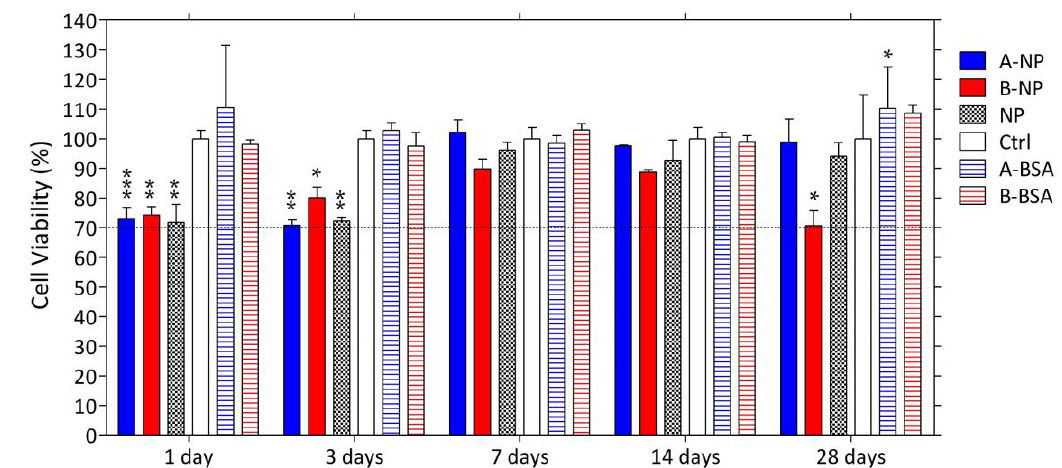
Figure 5. Cytotoxicity of the composite DDS to the ARPE-19 cells. The dashed line indicates 70% of cell viability. (*: p ≤ 0.05; **: p ≤ 0.01; ***: p ≤ 0.001).